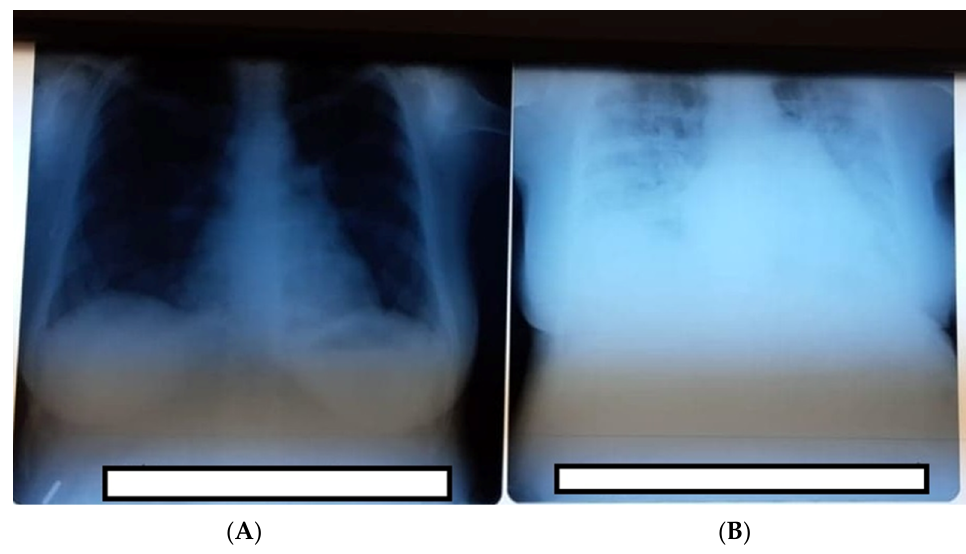
Figure 1. ( A ) Thoracic radiography was performed at admission with no obvious lesions. ( B ) Tho- Figure racic radiography third-day postpartum showing signs of severe COVID-19 pneumonia.